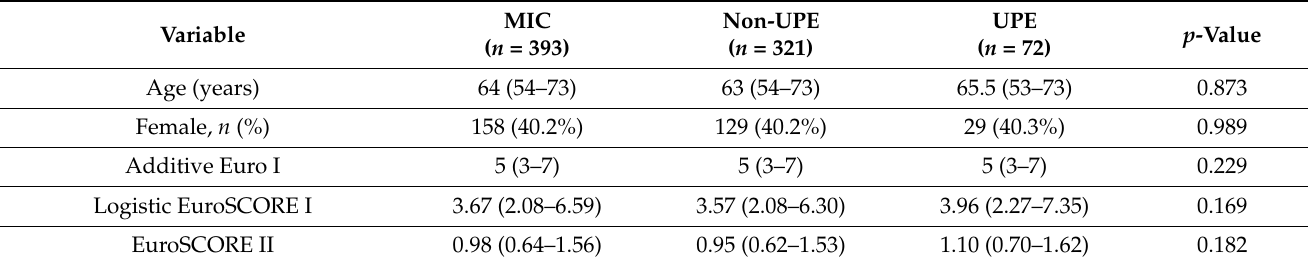
Table 1. Preoperative patient details of MIMVS